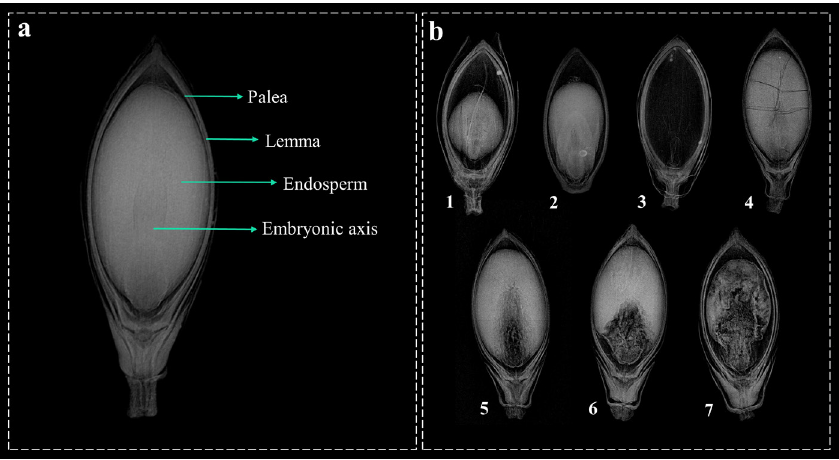
Figure 2. X-rays of Brachiaria seeds with indications